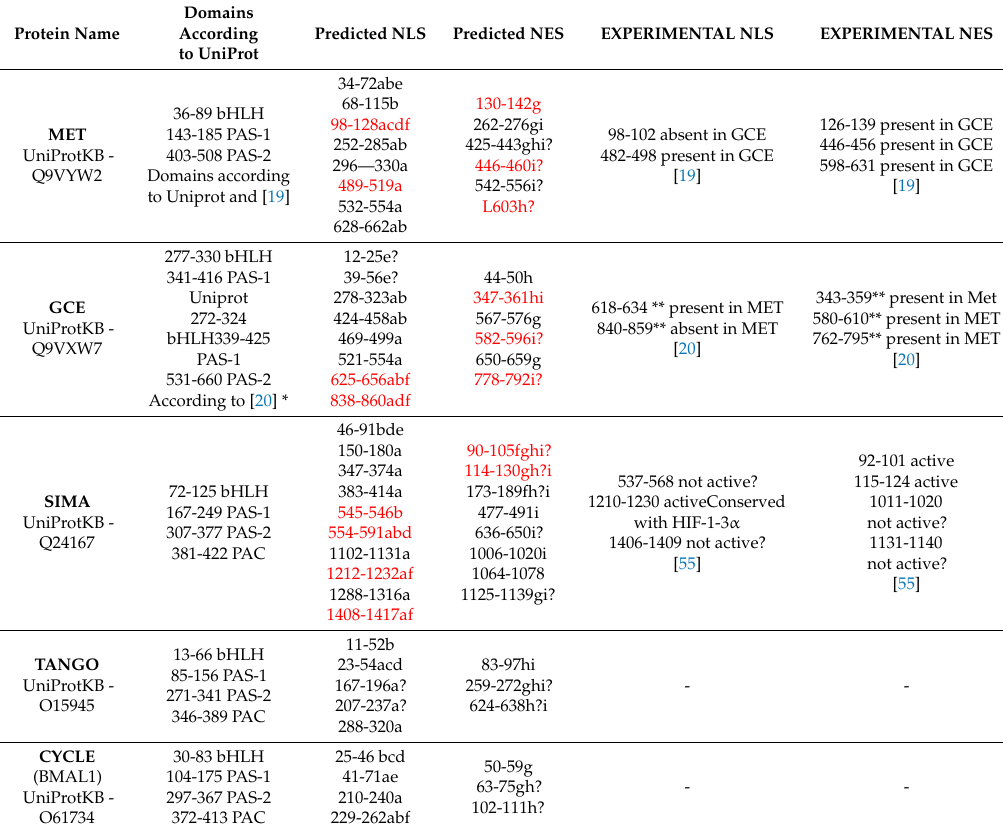
Figure 2. ClustalX alignment of DmCYCLE / hBMAL1 sequences in area of hBMAL1 localization signals [94]. ( A ) Sequences encompassing NLSs ( B ) Sequences encompassing NESs. Table 3. Summary of predicted and documented NLSs and NESs in selected Drosophila melanogaster bHLH-PAS